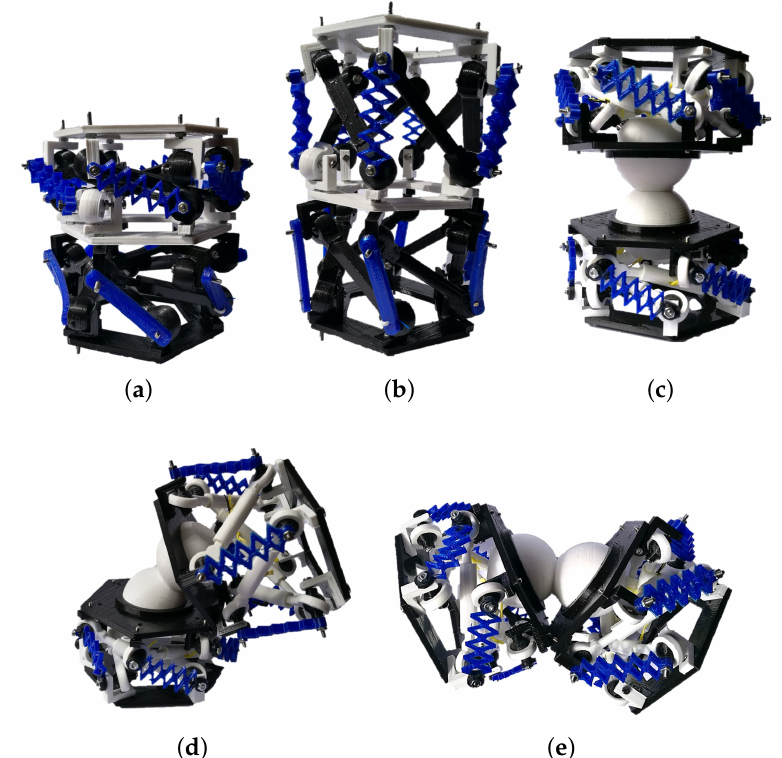
Figure 8. Assembled nested links prototype. ( a ) Two-sections link collapsed. ( b ) Two-sections link deployed. ( c ) Two single links with a joint. ( d ) Two single links with a joint, vertically rotated and one of them extended. ( e ) Two single links with a joint, horizontally rotated and